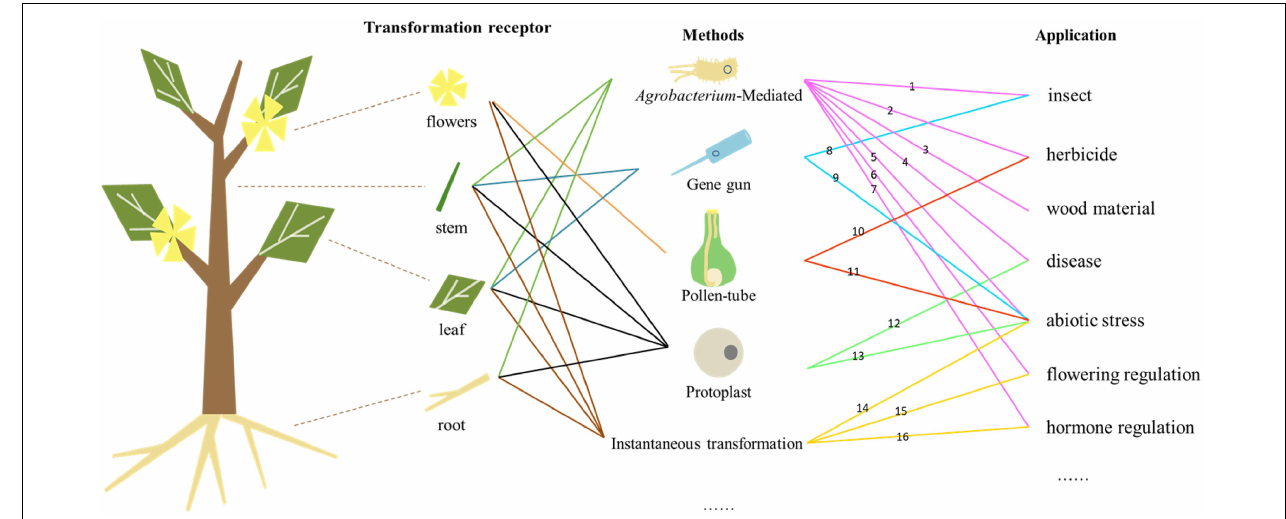
FIGURE 1 | Relationships among genetic transformation receptors, methods, and applications. Numbers represent different gene types. (1) Bt, API, etc., (2) Bar, aroA, GST, etc., (3) 4CL, C3H, C4H, etc., (4) TCS, PPV, WRKY, etc., (5) MBF, BADH, etc., (6) FT, LFY, etc., (7) GAUT, BAK, RGL, etc., (8) Bt, etc., (9) GERF, AREB, etc., (10) Bar, etc., (11) AFP, etc., (12) hph, etc., (13) FLA, etc., (14) DREBRB, ALDH21, etc., (15) SAG, etc., and (16) pBI121, etc.